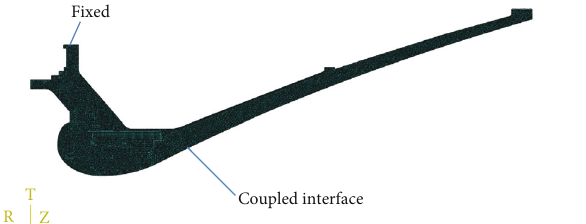
Figure 5: Solid domain computing